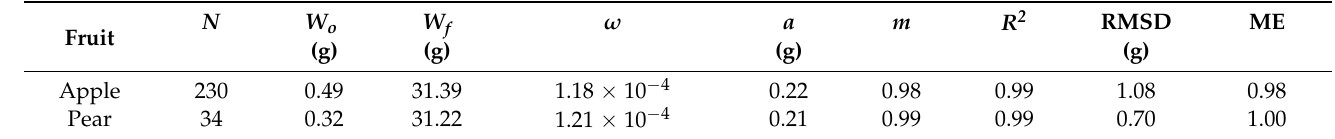
Figure 2. Individual fruit DW (g) in relation to the hourly thermal time ( ◦ C h) computed after full flowering. Data were collected in apple ( a ) and pear ( b ) experiments. The logistic equations fitted to the data are also shown. Table 4. Parameters of the logistic equation and statistics of the linear regression of predicted on observed values of DW of individual fruits of apple and pear trees grown in the experimental orchards. All fruits monitored were subjected to little or no competition from the fruits in their vicinity 1